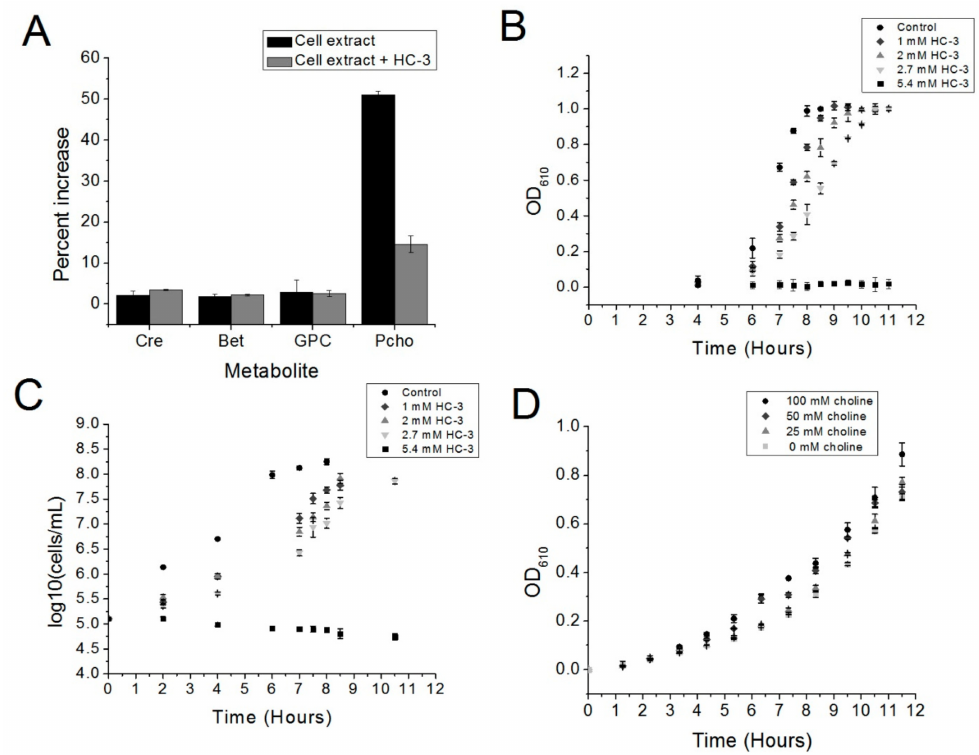
Figure 2. ( A ) The ability of HC-3 to inhibit the choline kinase enzymatic activity of S. pneumoniae cell extracts was monitored by mass spectrometry. The concentrations of glycerophosphocholine (GPC), betaine (BET), and creatinine (Cre) were quantified as a control for the amount of cell extract in each reaction. Reactions were normalized against a control reaction lacking ATP (not seen). There was a notable increase in the amount of phosphocholine in solution when ATP was added to the reaction mix (Cell extract alone), and an evident reversal of phosphocholine production when HC-3 was added (Cell extract + HC-3). ( B,C ) R6 cells were grown in either a BHI-CAT control or increasing concentrations of Hemicholinium-3 (HC-3). ( B ) Cell growth was monitored by measuring the optical densities (O.D.) of the cultures at 610 nm. ( C ) R6 cell viability was determined by measuring the bacterial populations using plating methods. ( D ) R6 cells were grown in the presence of a fixed amount of HC-3 (2.7 mm) and varying concentrations of choline. Cell growth was monitored by measuring the optical density at 610